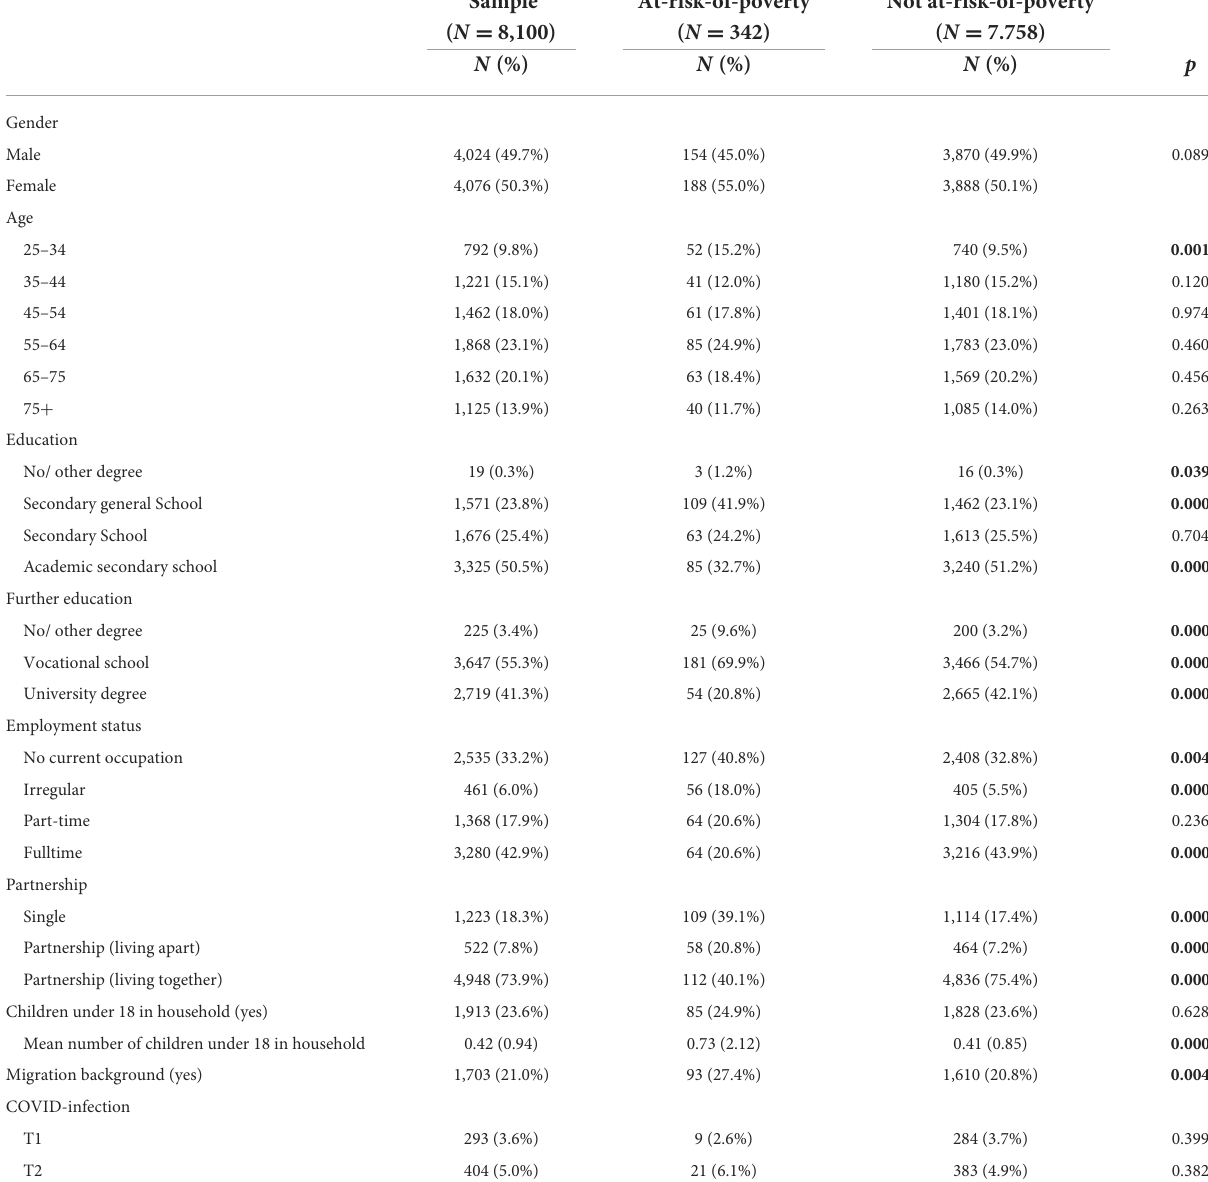
TABLE 1 Socio-demographic characteristics of respondents living and not living at-risk-of-poverty. Sample At-risk-of-poverty Not